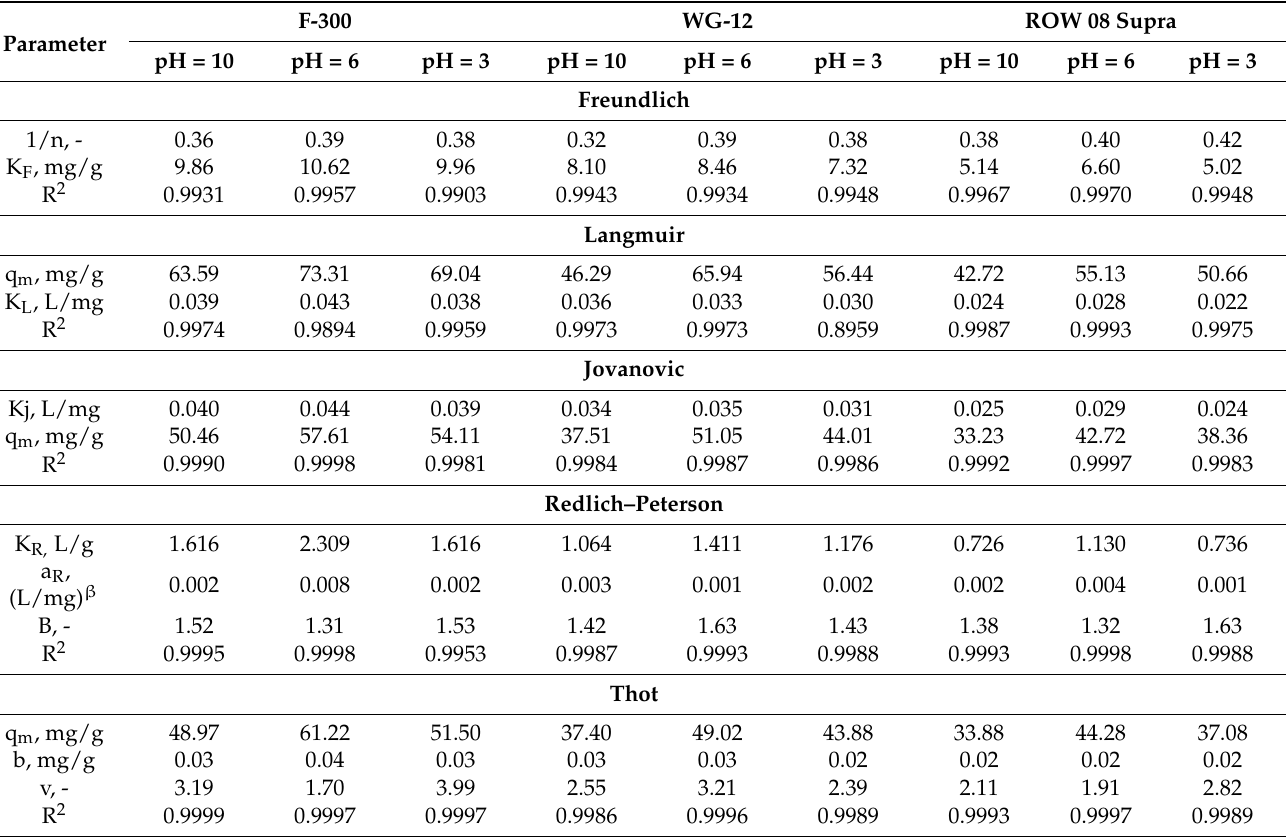
Table 8. Constants of oxytetracycline absorption isotherms on activated carbons F-300, WG-12, ROW 08 Supra from solutions with pH 3; 6 and 10.